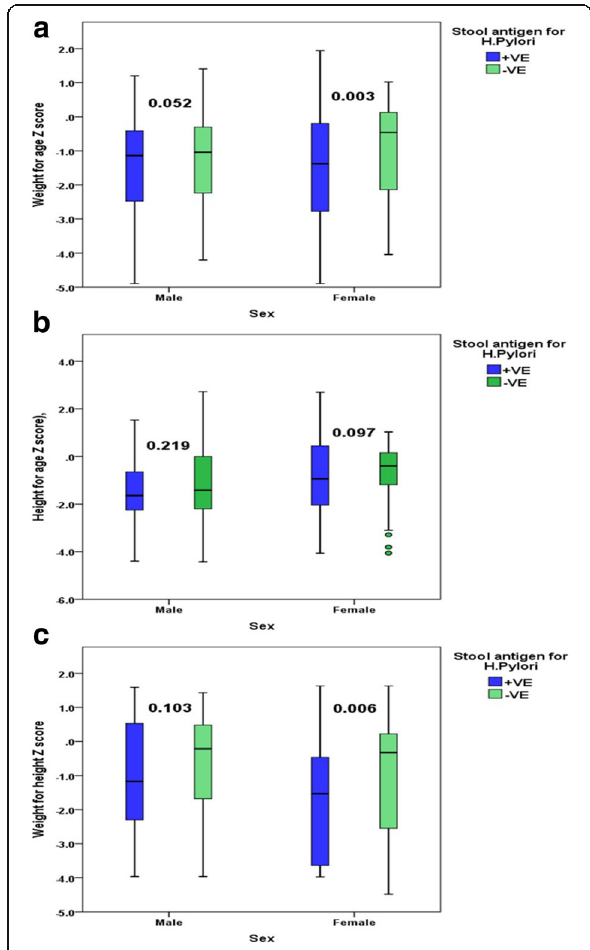
Fig. 1 a Box plot showing distribution of WAZ in relation to sex and H. pylori infection. b Box plot showing distribution of HAZ in relation to sex and H. pylori infection. c Box plot showing distribution of WHZ in relation to sex and H. pylori